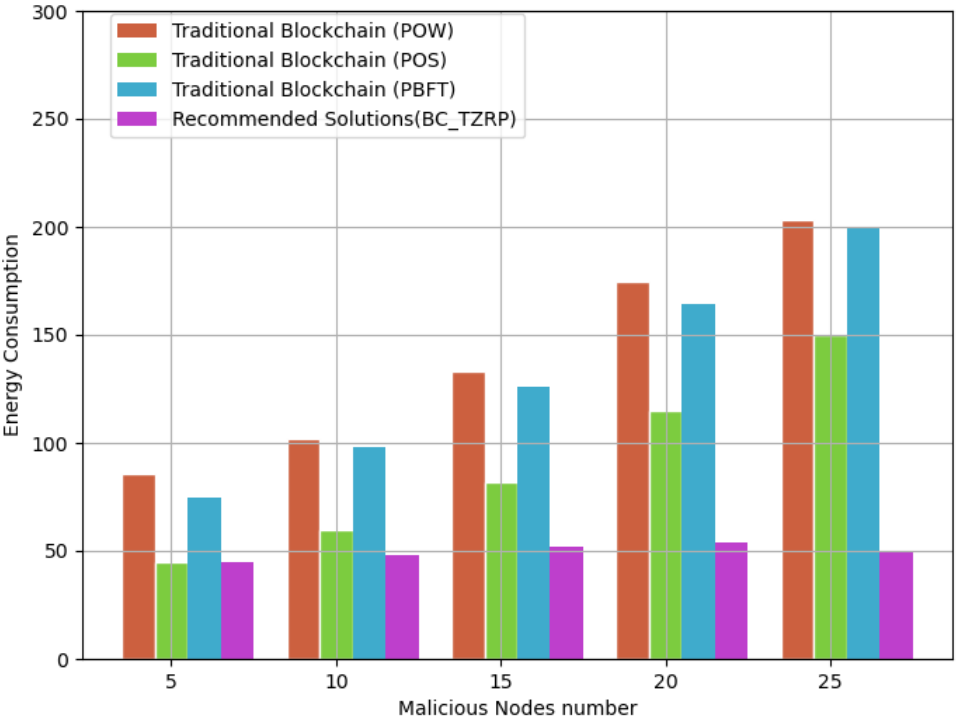
Figure 8. Comparison of energy consumption in a consensus process with different numbers of malicious